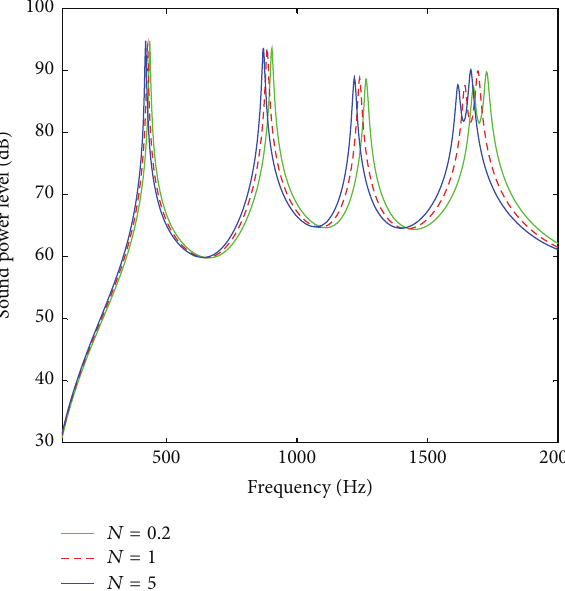
Figure 7: Sound radiation of FGM plates with different power-law index.